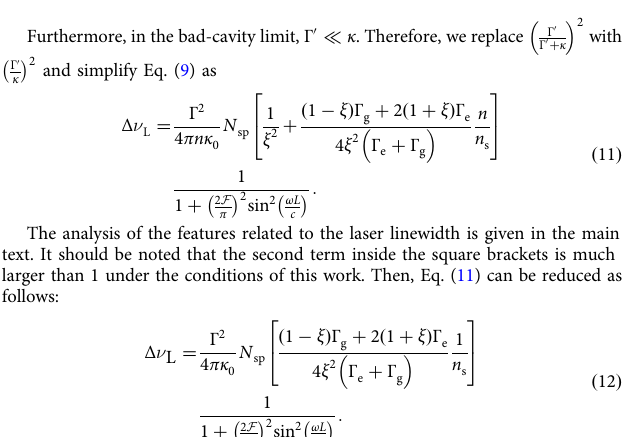
Fig. 9 Quantum-limited linewidth Δ ν L as a function of the phase shift Δ ϕ . The black-square dotted line and the blue dotted line represent the results of thermal- and cold-atom as gain medium,